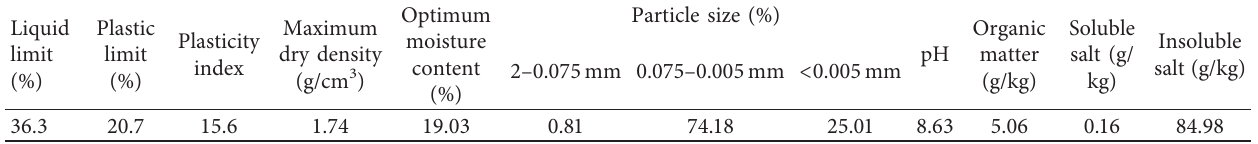
Table 1: The parameters of the